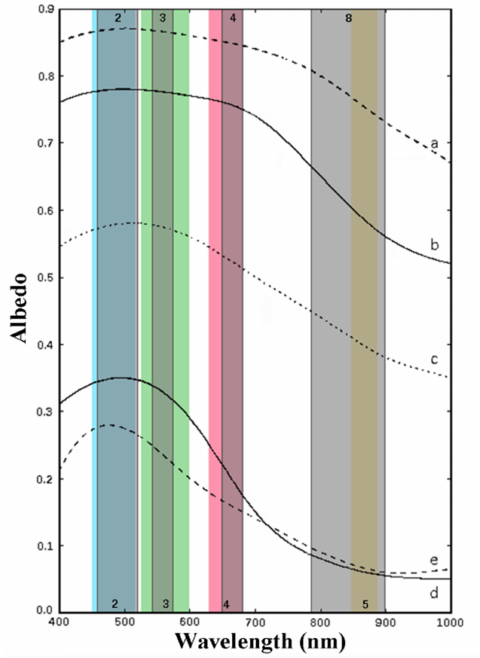
Figure 4. Spectral albedos for different surface types on Arctic sea ice (the values are from [20]): ( a ) snow-covered ice; ( b ) cold bare ice; ( c ) melting bare ice; ( d ) young melt pond; and ( e ) mature melt pond. The colored columns except the purple columns display the L8 bands used, and the band numbers are at the top of the columns. The colored columns display the S2 bands used, and the band numbers are in the top of the columns. The dark-gray columns represent the corresponding L7 bands, and the band numbers are at the bottom of the